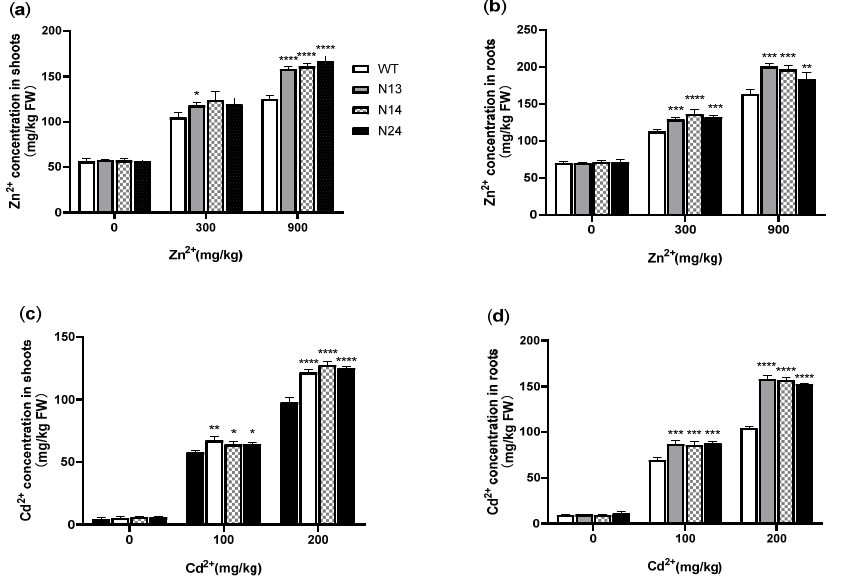
Figure 4. Zn 2+ and Cd 2+ concentrations of transgenic and WT tobacco in shoots and roots. ( a ) Zn contents in shoots. ( b ) Zn contents in roots. ( c ) Cd contents in shoots. ( d ) Cd contents in roots. WT: Wild-type tobacco. N13, N14, N24: Three homozygous transgenic tobacco lines (T 2 ). The 4 − week − old WT and transgenic plants were treated under Zn 2+ (0, 300, or 900 mg/kg) or Cd 2+ (0, 100, or 200 mg/kg) for 3 weeks, respectively. Asterisks indicate the significant difference between transgenic lines and WT (*, p < 0.05; **, p < 0.01; ***, p < 0.001; ****, p < 0.0001).